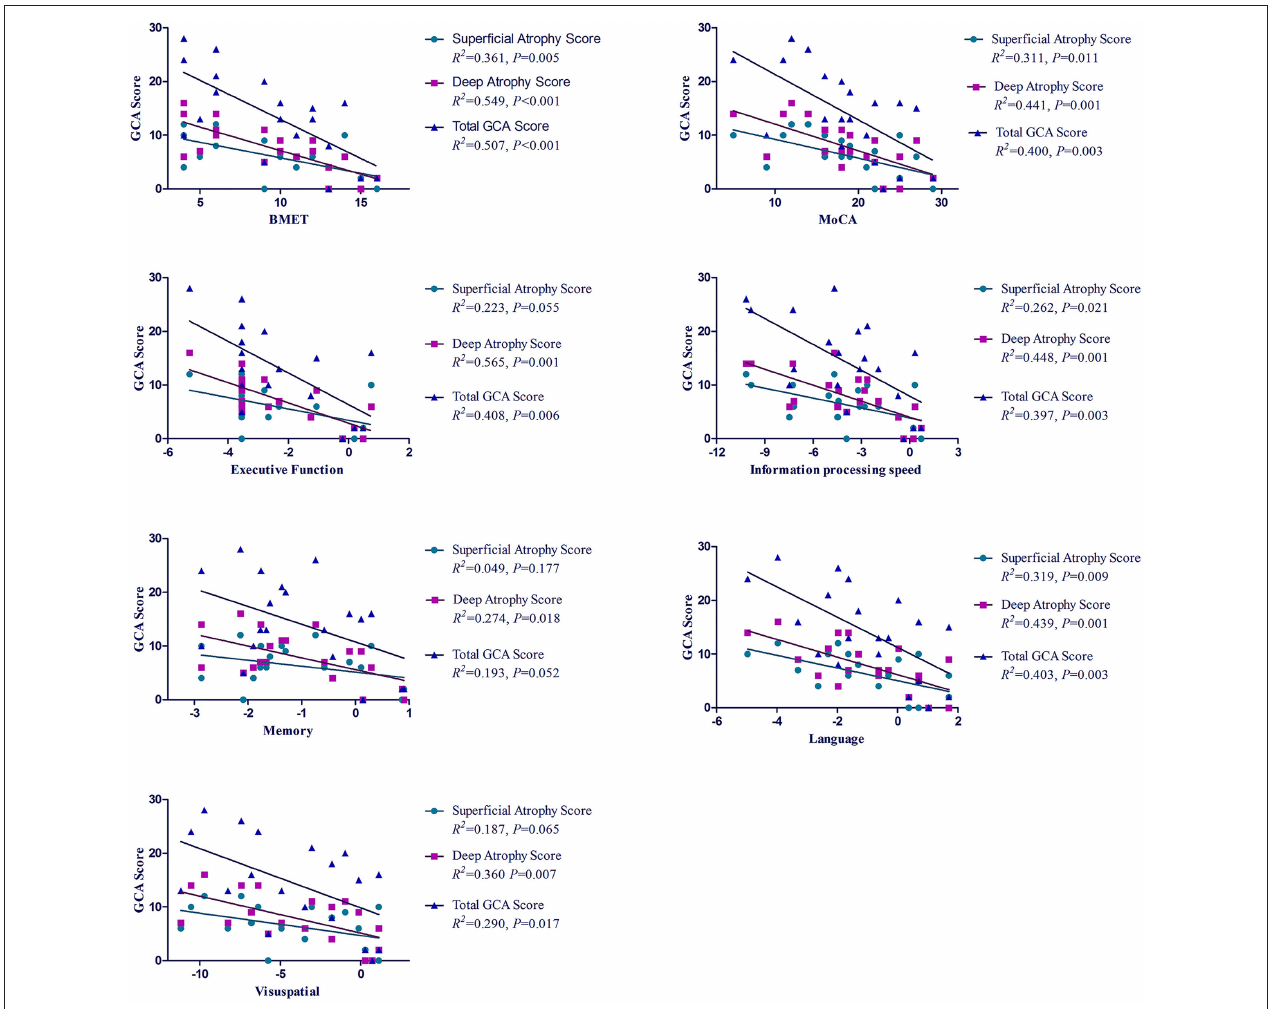
FIGURE 4 | R 2 for the association between GCA score and cognitive impairment in patients with CADASIL. R 2 , coefficient of determination; GCA, Global Cortical Atrophy; CADASIL, Cerebral Autosomal-Dominant Arteriopathy with Subcortical Infarcts and Leukoencephalopathy; BMET, Brief Memory and Executive Test; MoCA, Montreal Cognitive